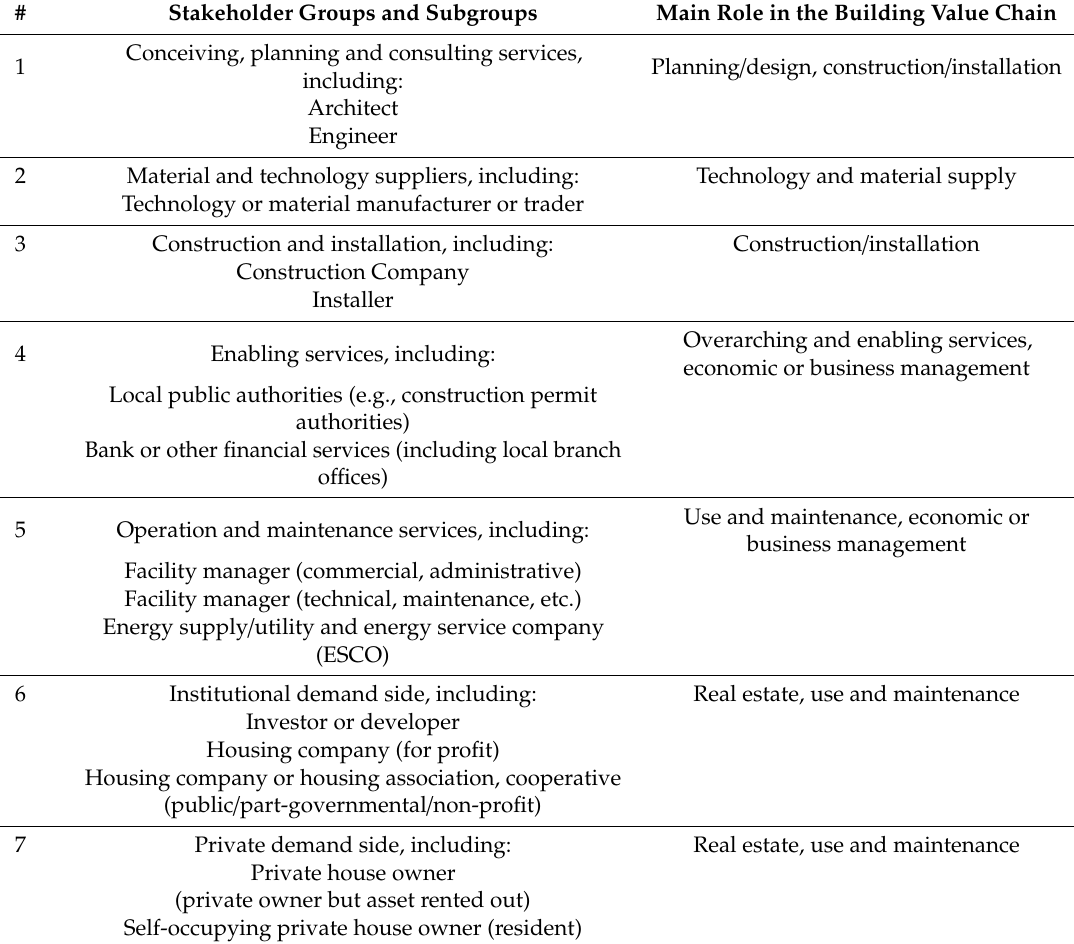
Table 1. Stakeholder groups and subgroups actively involved in the uptake of energy-e ffi cient (EE) technologies in residential building projects [40].